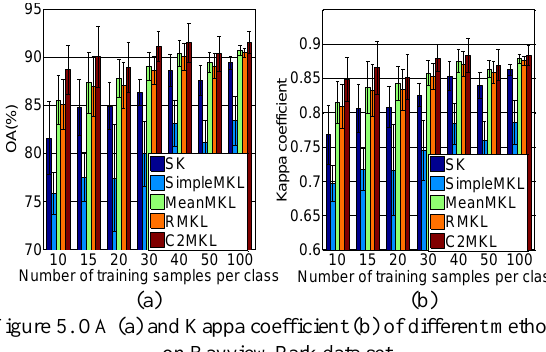
Figure 5. OA (a) and Kappa coefficient (b) of different methods on Bayview Park data set.